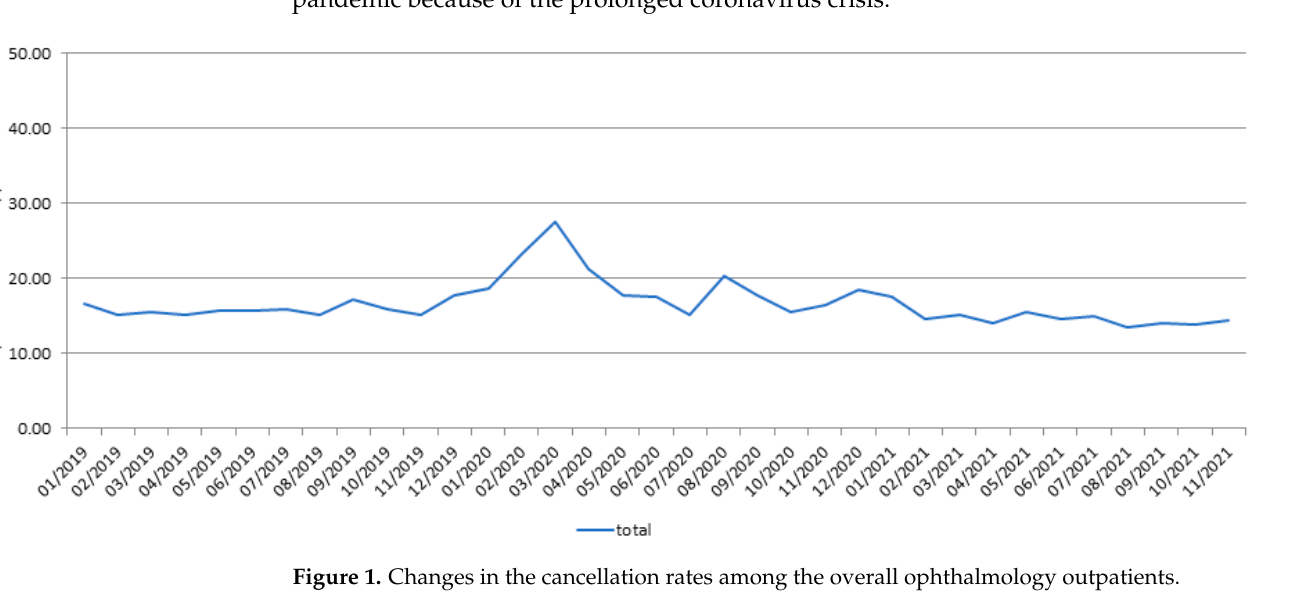
Table 1. Changes in the cancellation rates among the overall ophthalmology outpatients. Year Cancellation Visit Cancellation Rate p -Value 2019 6700 35,380 15.92% 7335